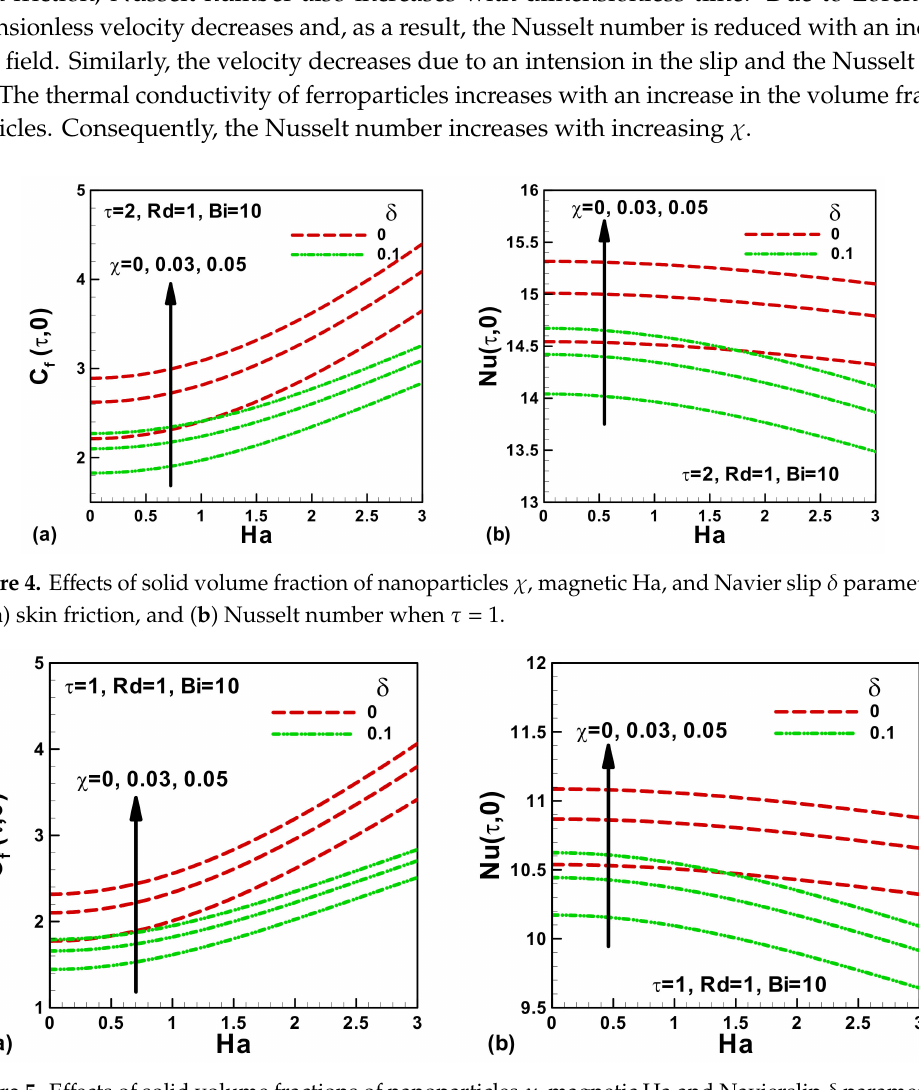
Figure 5. E ff ects of solid volume fractions of nanoparticles χ , magnetic Ha and Navierslip δ parameters on ( a ) skin friction, and ( b ) Nusselt number when τ =